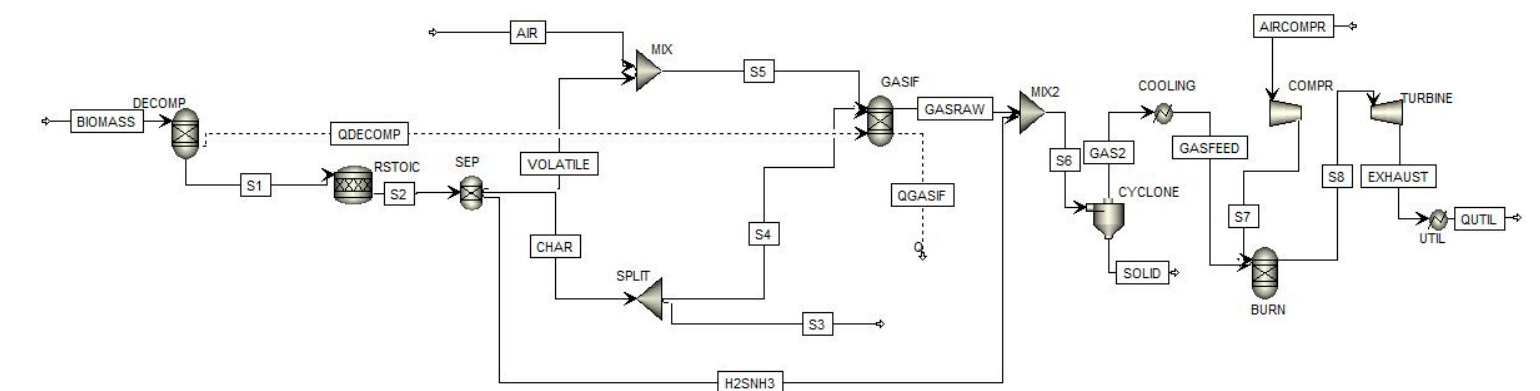
Figure 2. Flowchart of the plant evaluated in this study (the hatched streams are the heat streams, representing thermal recoveries; the continuous streams are the material streams), considering air as the gasifying agent.